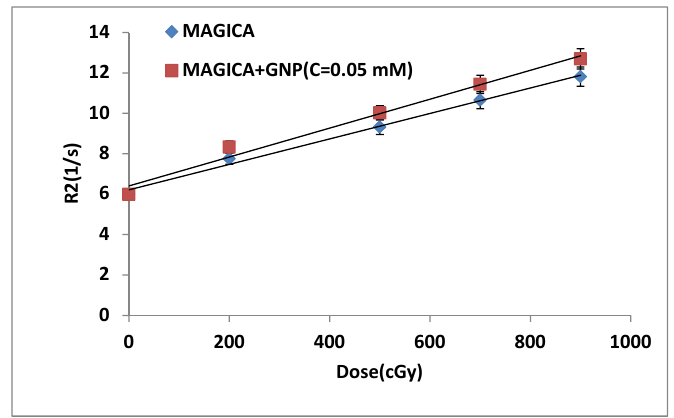
Fig. 6. Dose enhancement factor performed with MAGICA gel with 0.05 mM GNPs concentration Fig.7